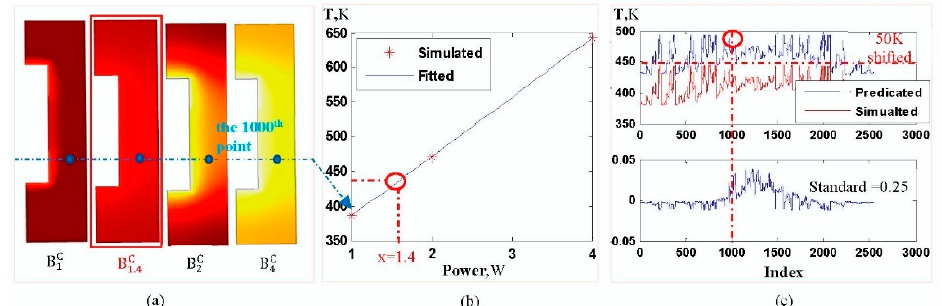
Figure 4. Illustration of the online fitting asset from offline simulations using the thermal stress ex- periment in COMSOL library applications. ( a ) The simulated image of temperature distribution under four boundary conditions denoted as B (cid:2869)(cid:2887) ,B (cid:2869).(cid:2872)(cid:2887) ,B (cid:2870)(cid:2887) , and B (cid:2872)(cid:2887) , with indicative points (the 1000th point); ( b ) the 2nd-order poly-function fitting the “simulated” data for the 1000th point to predicate its corresponding temperature under the boundary condition, B (cid:2869).(cid:2872)(cid:2887) ; ( c ) the comparison of the deviation and standard between the predicated and the simulated, where the deviation of temperature is less than 0.05 K and the standard is 0.25.